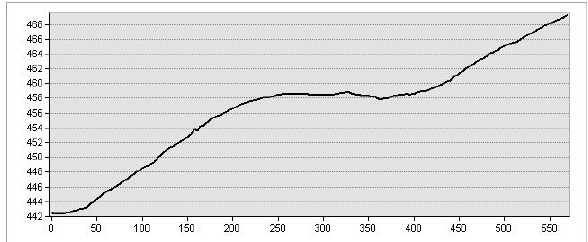
Figure 2. Elevation profile in the Dědice